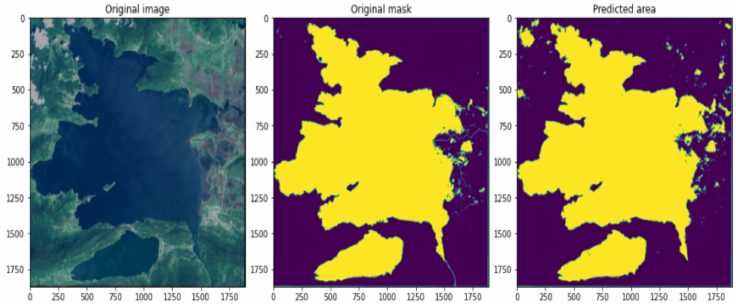
Figure 8. Predicted mask area for the water body.